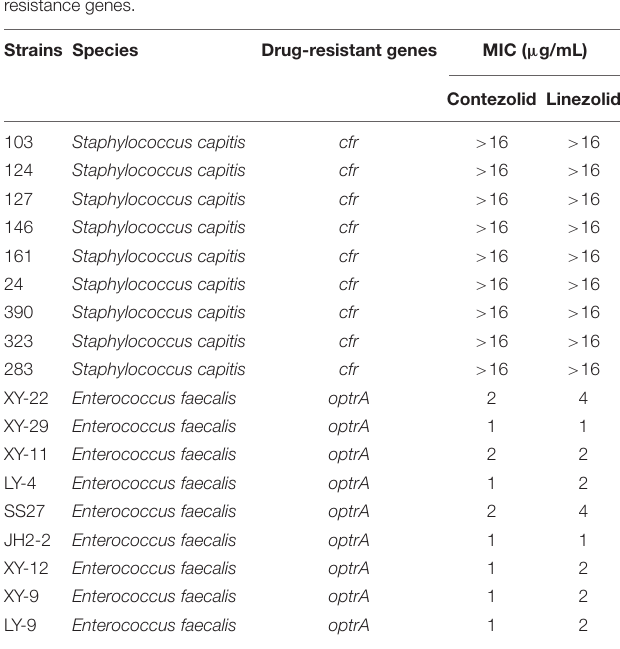
TABLE 4 | In vitro activity of contezolid and linezolid against strains with linezolid resistance